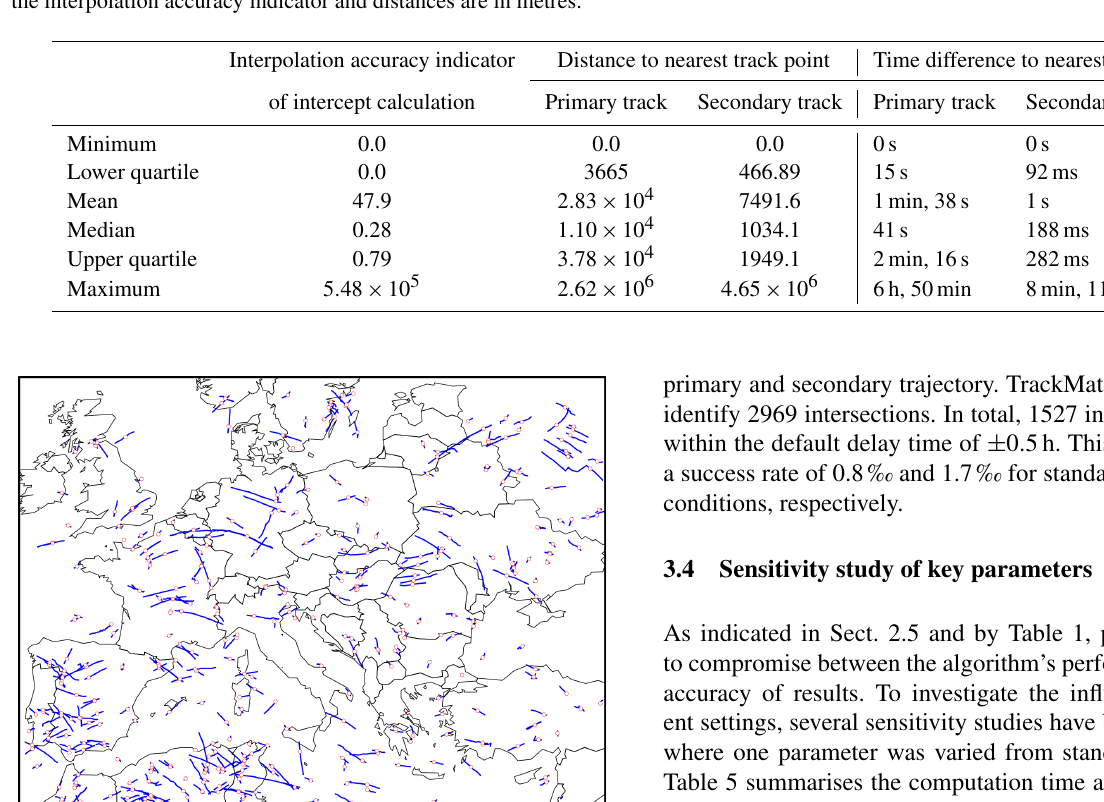
Table 4. Statistics on the interpolation accuracy indicator and the spatial and temporal distances of the calculated intersection to the nearest measured track point of the primary or secondary data set for the run using data of February 2012 by the DOT Volpe Center. The units for the interpolation accuracy indicator and distances are in metres.